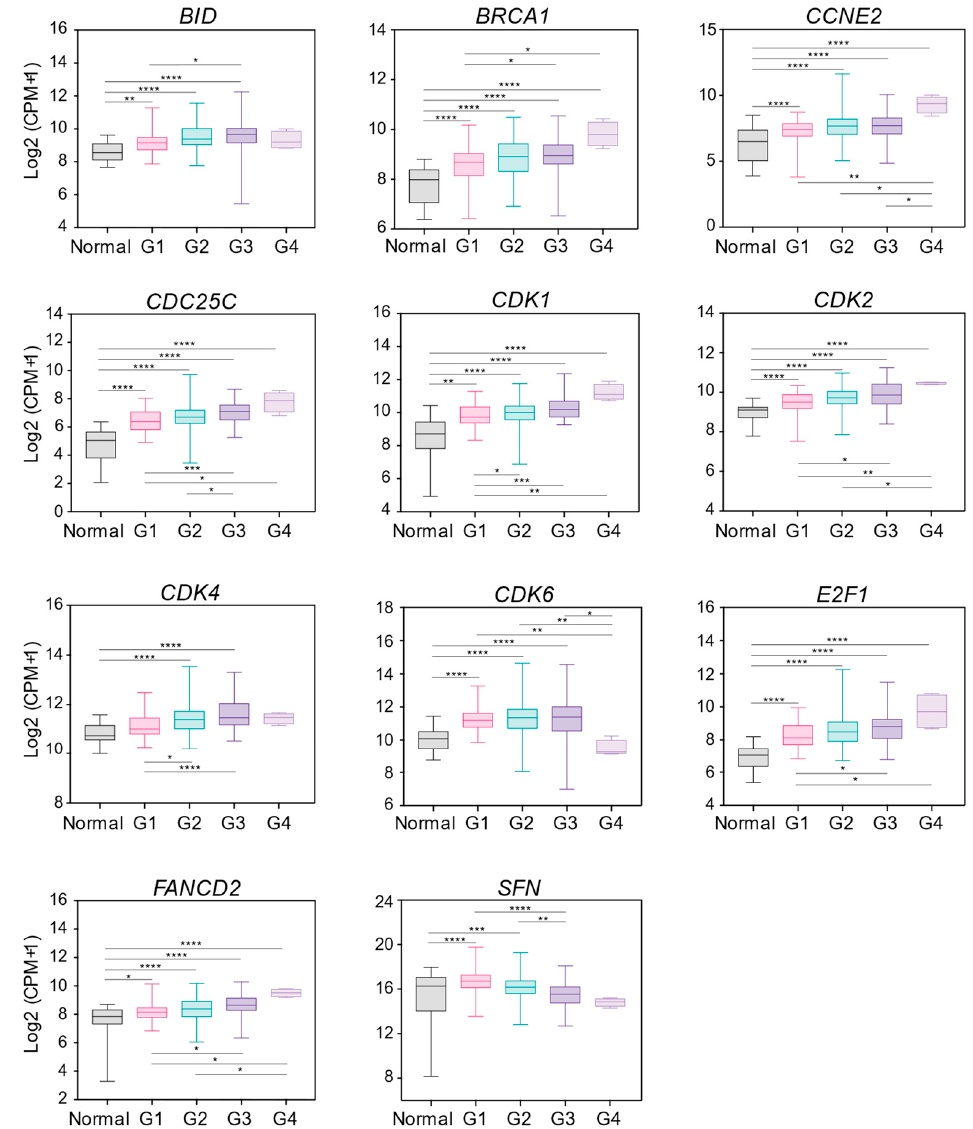
Figure 2. DDR gene expression correlation with clinical parameters in OSCC patients. Box plots showing the correlation between mRNA expression and the tumor grade. G1 (Grade 1) well differentiated (low grade); G2 (Grade 2) moderately differentiated (intermediate grade); G3 (Grade 3) poorly differentiated (high grade); G4 (Grade 4) undifferentiated (high grade). Normal (normal tissue) n = 32, G1 n = 50, G2 n = 189, G3 n = 64, G4 n = 4 (Supplementary Tables S1 and S3). One-way ANOVA for multiple comparisons. * p < 0.05, ** p < 0.01, *** p < 0.001, **** p < 0.0001. Groups without statistical significance were unmarked. CPM; counts per million mapped reads.